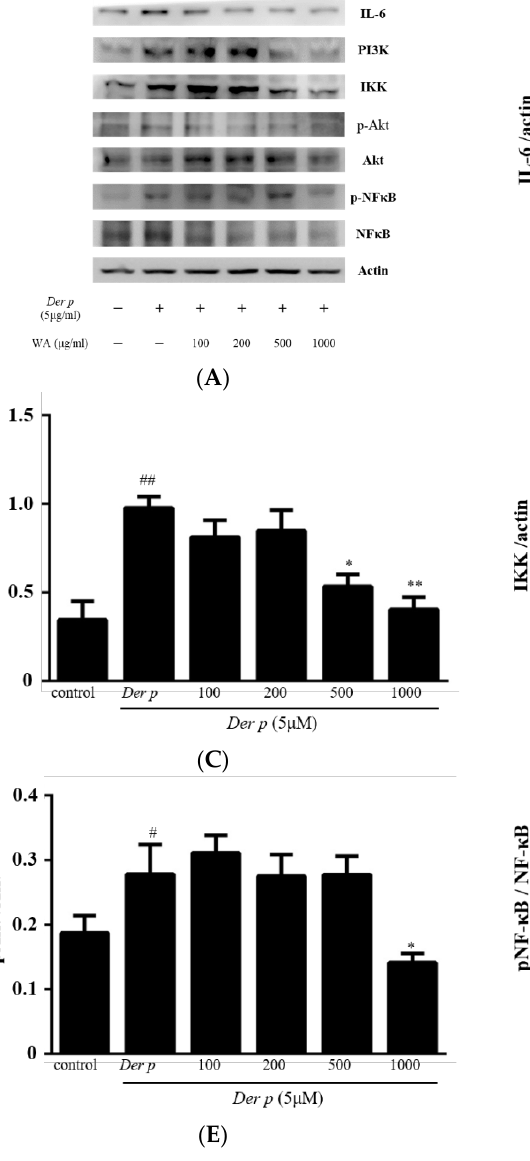
Figure 7. Effect of WA fraction on IL-6/PI3K/Akt/NF- κ B expression in Der p-stimulated A549 cells. The cells were pretreated without ( − ) treatment (Control), with (+) Der-p alone or Der-p plus various concentrations (100, 200, 500, and 1000 μM) of WA fraction for 24 h ( A ). Proteins isolated from A549 cells were probed with antibodies against ( B ) IL-6, ( C ) PI3K, ( D ) IKK, ( E ) p-Akt, and ( F ) p-NF κ B. The same membrane was re-probed with the antibody for β -actin to verify that equal amounts of protein were loaded. Data derived are presented herein as mean ± SEM. # p < 0.05 and ## p < 0.01 versus the control group, * p < 0.05, ** p < 0.01 and *** p < 0.001 versus the Der p group.